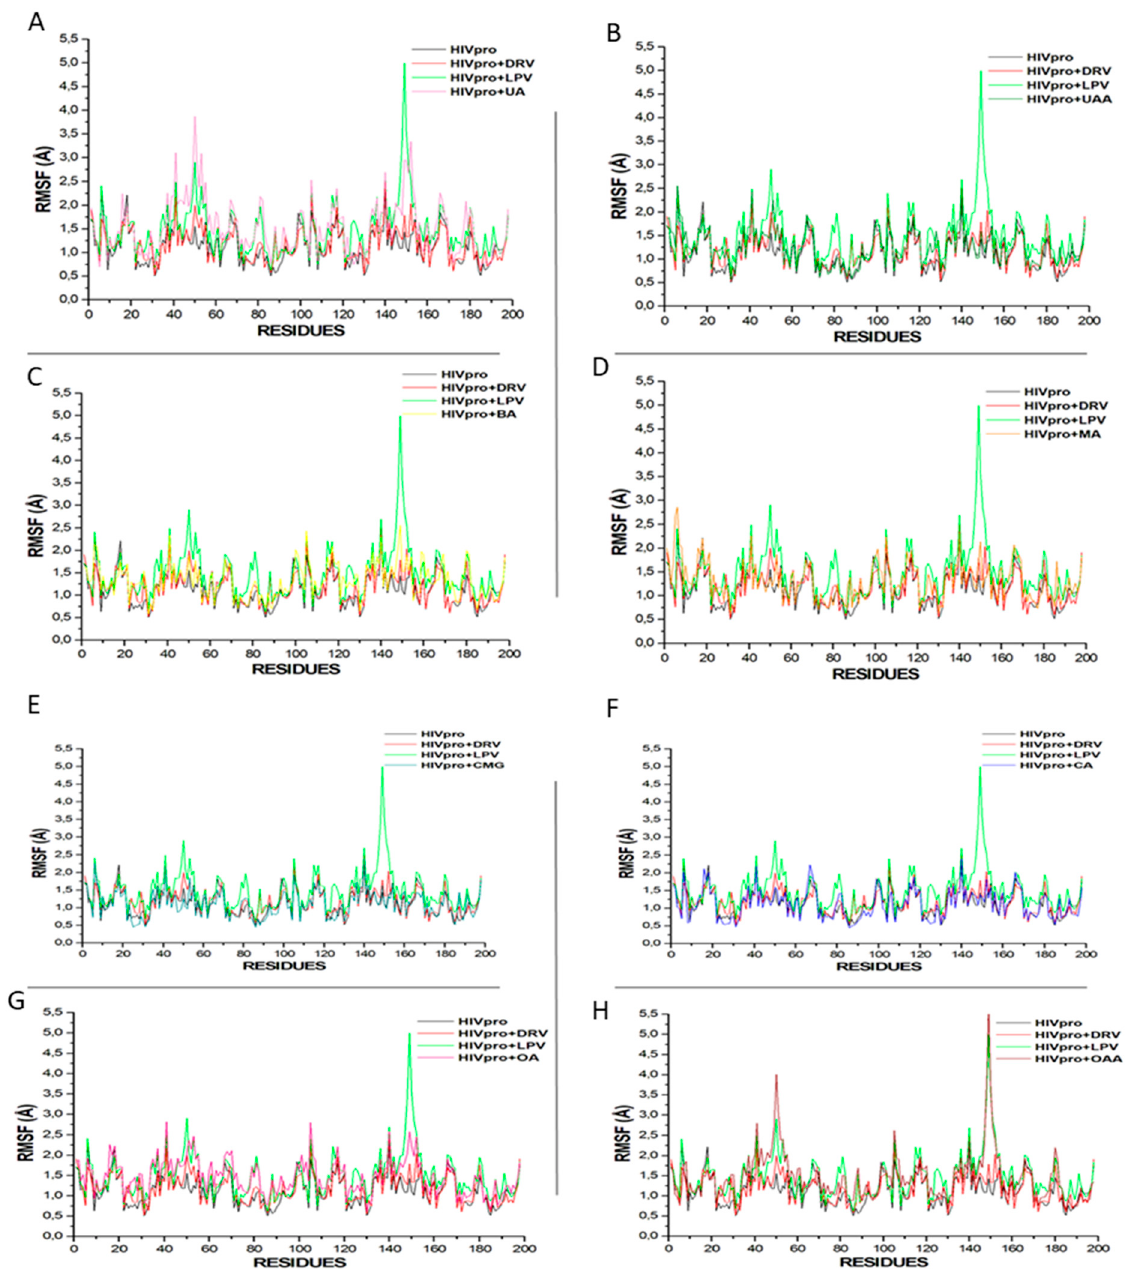
Figure 4. Comparative RMSF plots of residue-based average C- α fluctuations of free HIVpro and that bound with LPV, DRV, and ( A ) UA, ( B ) UAA, ( C ) BA, ( D ) MA, ( E ) CMG, ( F ) CA, ( G ) OA, and ( H ) OAA systems.